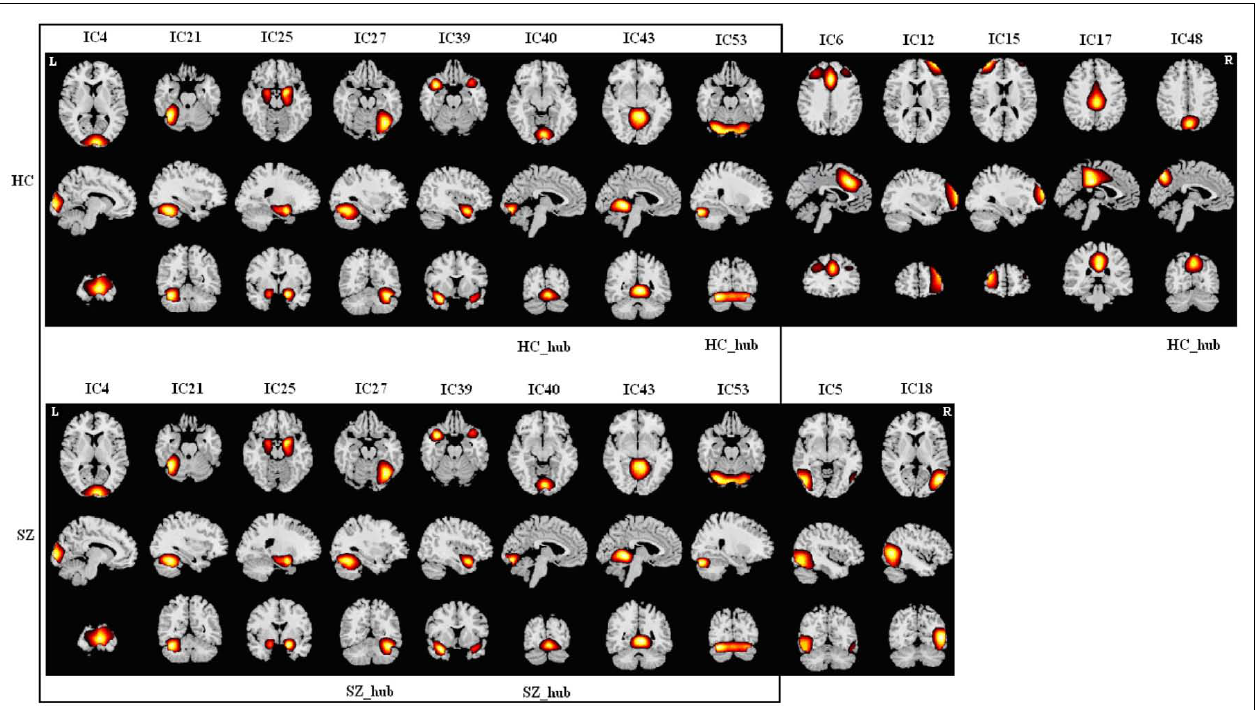
components, two cingulum components, and one precuneus component. SZs have two additional components including one occipital component and one temporal component. As the components of this module in HCs represent regions distributed across almost the whole brain, we designated this module as “Global Module” (G1 Module).There are three hubs in HCs and two hubs in